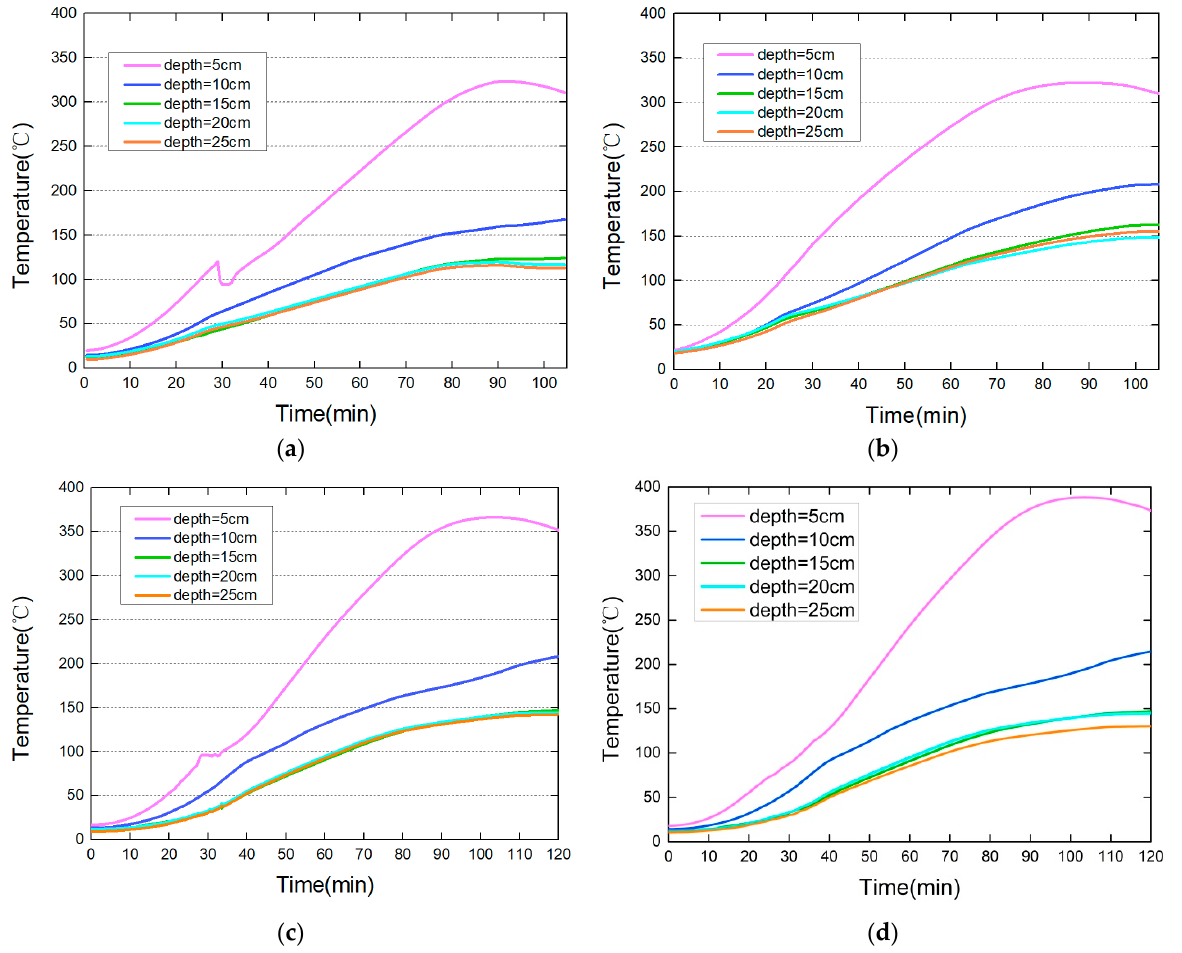
Figure 4. Temperature development inside the concrete samples: ( a ) 800 °C, samples without drying; ( b ) 800 °C, samples with drying at 105 °C for 36 h; ( c ) 1000 °C, samples without drying; ( d ) 1000 °C, samples with drying at 105 °C for 36 h.